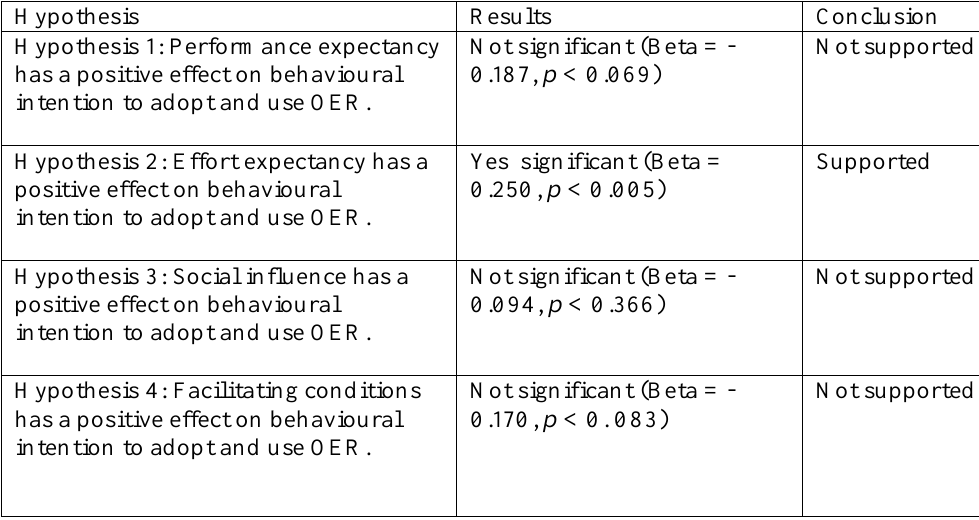
Summary of Results Hypothesis